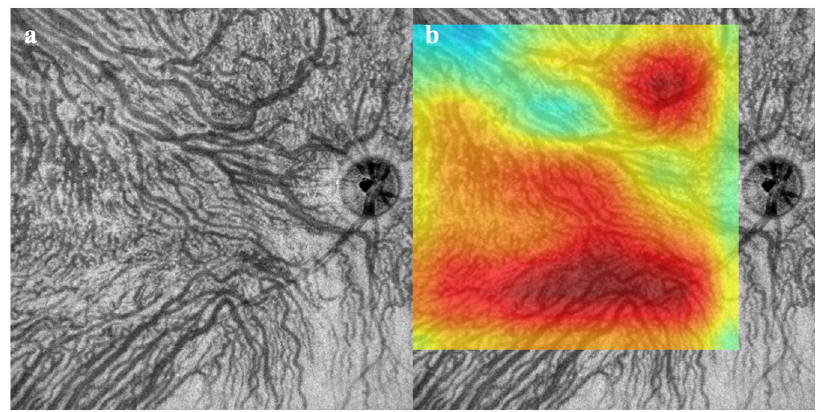
Fig 3. Images from normal eye. a. Choroidal vessels are distributed in a symmetrical pattern from the superior and inferior sectors. Both Convolutional Neural Network models determined that this was obtained from a normal eye. b. Heatmap superimposed OCT en face image. Deep learning focused on the uniform choroidal vessels and the area occupied by choroidal vessels in the image. The active region was